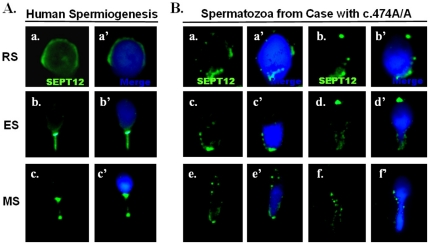
Expression patterns of SEPT12 human male germ cells with the c.474G/G (wild) and c.474A/A genotypes.(A.) Detection of SEPT12 signals during human spermiogenesis. (a.–a′): Round Spermatids (RS), (b.–b′) Elongating Spermatids (ES) and Mature Sperm (MS). Left: SEPT12 signal (green); Right: merge of SEPT12 (green) and DAPI (light blue) signals. (B.) Varied type of spermatozoa isolated from cases with the c.474A/A genotype. Left: SEPT12 signal (green); Right: merge of SEPT12 (green) and DAPI (light blue) signals (Magnification: ×1,000).